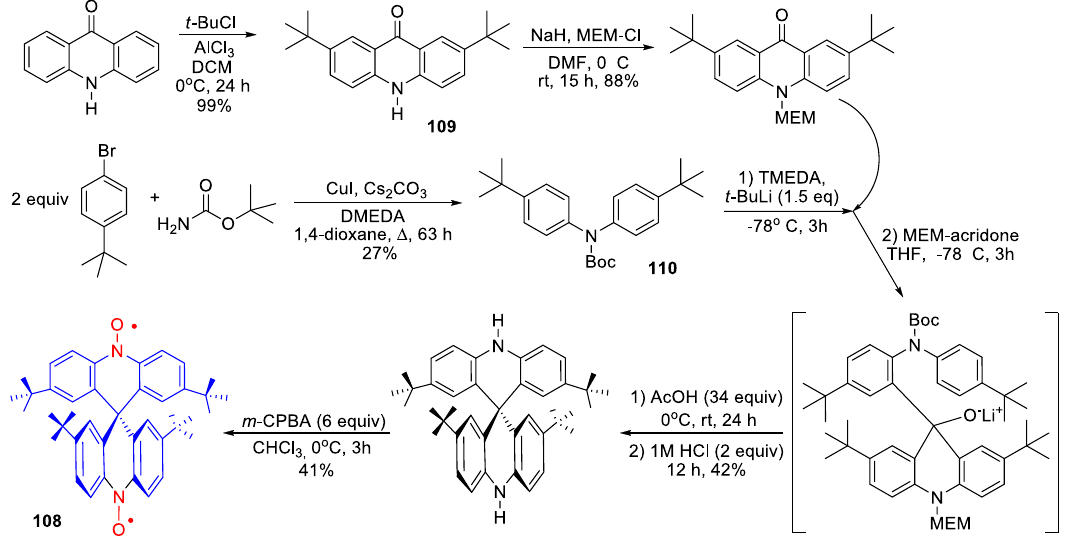
Figure 6. Crystal structures of spirobi[acridine] SNRs: ( a ) monoradical 106 and ( b ) diradical 107 . A decade later, the investigation of Ishida et al. was successful; recently, a publication appeared on the synthesis of paramagnetic spirocyclic nitroxyl diradical (SNDR) 108 with the largest value of ferromagnetic exchange in the series of spiro compounds, 2 J / k B = + 23( 1 ) K [79]. Crystallographic analysis clarified the D 2 d molecular structure, suggesting the degeneracy of SOMOs. The introduction of four tert -butyl groups at the para -position of the benzene cycle in the biacridine system relative to the NO fragment (Scheme 20) has made it possible to completely suppress the effect of the intermolecular antiferromagnetic interaction of the diradical molecules. The key base compound in a six-step sequence, di- tert -butyl–substituted acridone 109 , is obtained quantitatively by Friedel–Crafts alkylation of acridone [124]. In a 2020 paper, the same authors showed that, by changing the number of tert -butyl groups (0 → 2 → 4) in the molecule of a spirobiacridine diradical, it is possible to control the exchange interaction of unpaired electrons in the molecule by fine-tuning the intermolecular distances [125]. The corresponding di- tert -butyl diradical is obtained by a similar procedure from diarylamine 110 and MEM-protected acridone as starting blocks.